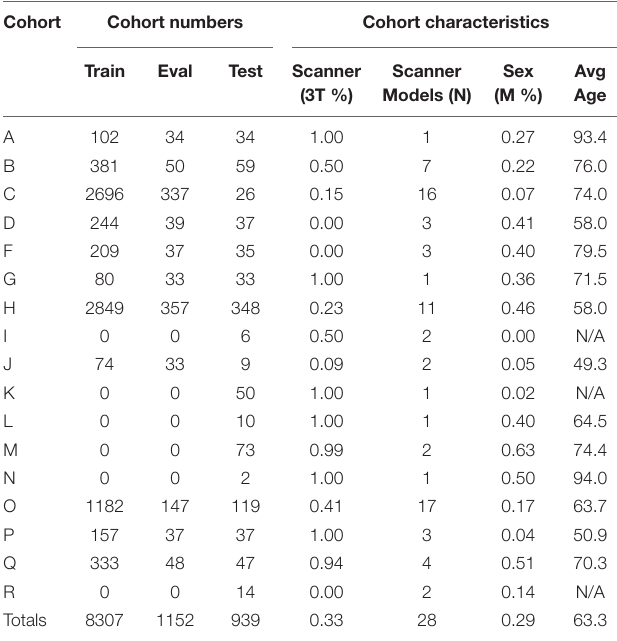
TABLE 2 | Imaging sources for our ground truth data.